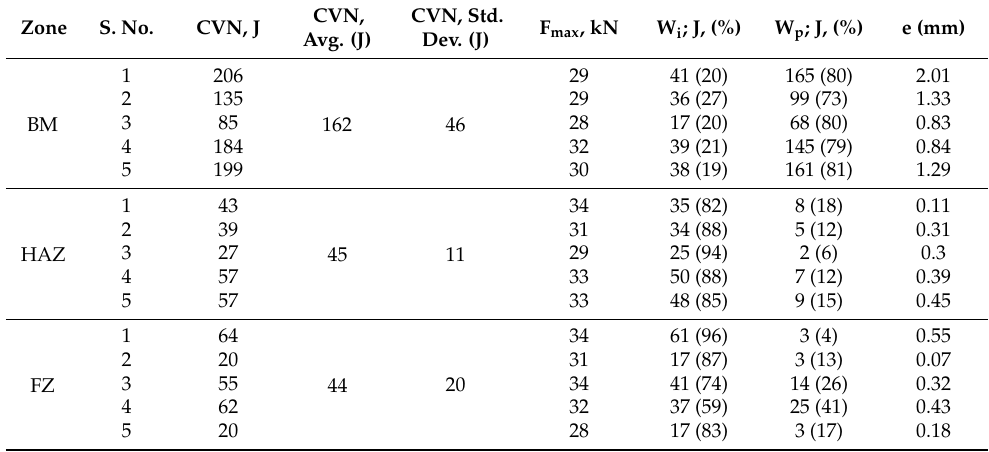
Table 11. Measured CVN values of EB welded S960QL joints.